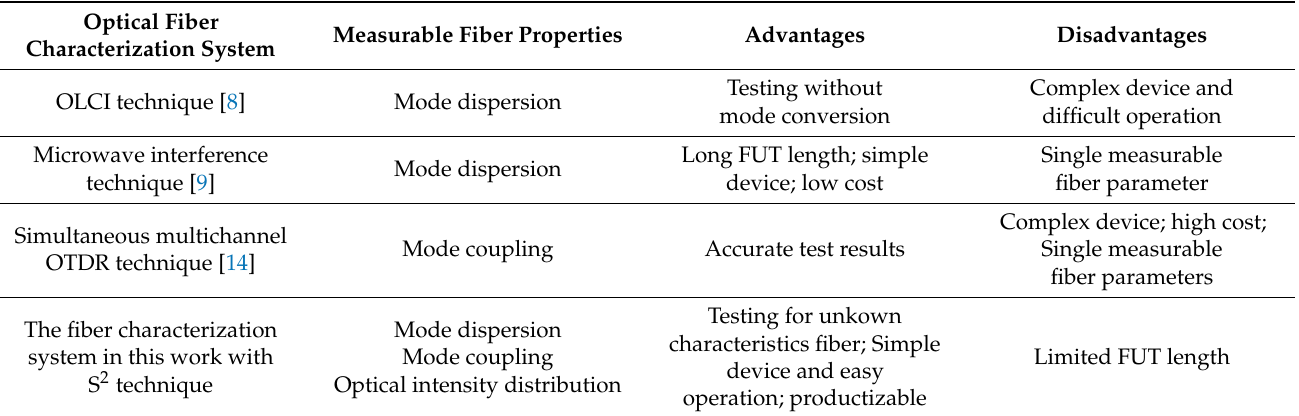
Table 2. Summary of optical fiber characterization techniques and advantages and disadvantages